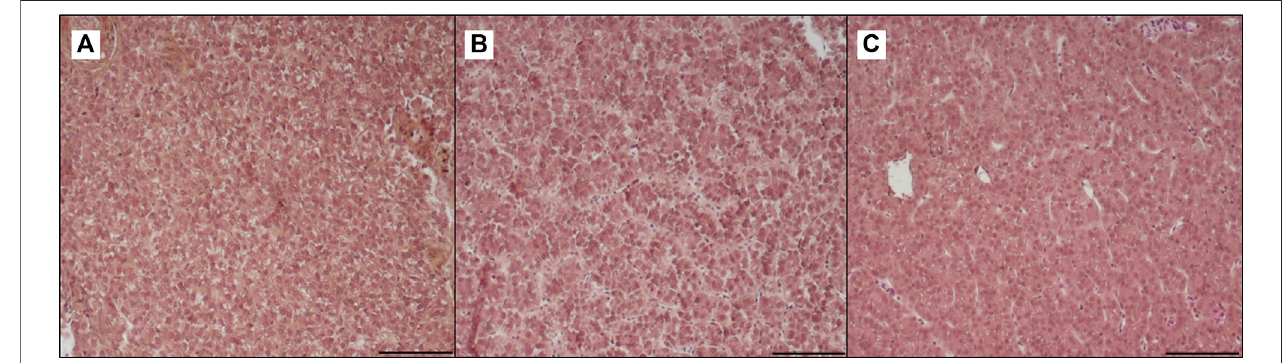
FIGURE 7 | Light microscopy of liver of trout fed control diet (A) , poultry by-products meal diet (B) and insect meal diet (C) . Hematoxylin and eosin, scale bar = 100 μ m.